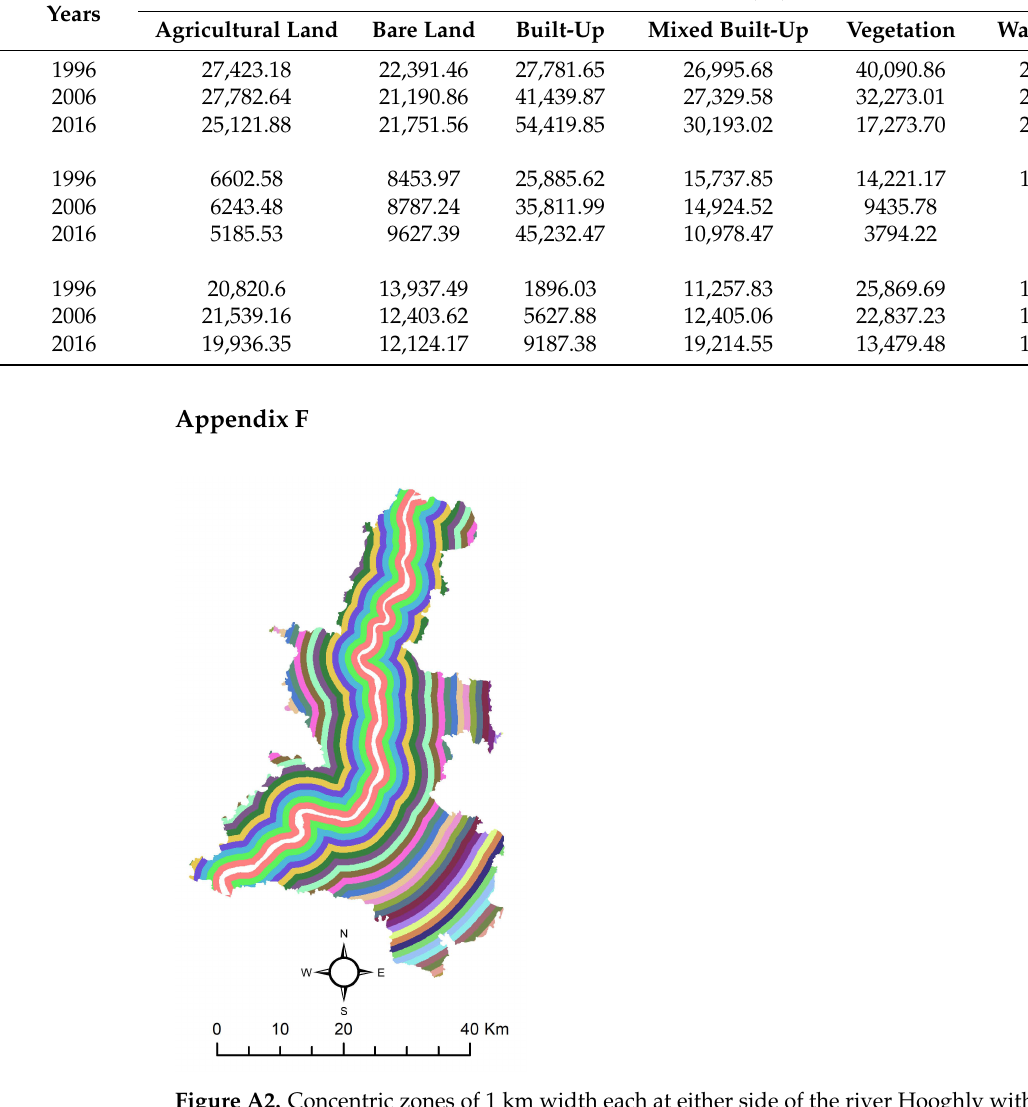
Figure A2. Concentric zones of 1 km width each at either side of the river Hooghly within the